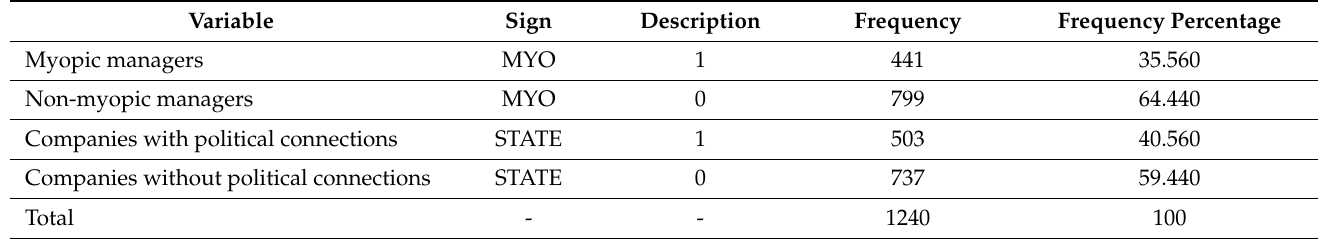
Table 3. The frequency distribution of myopia variable of managers and political